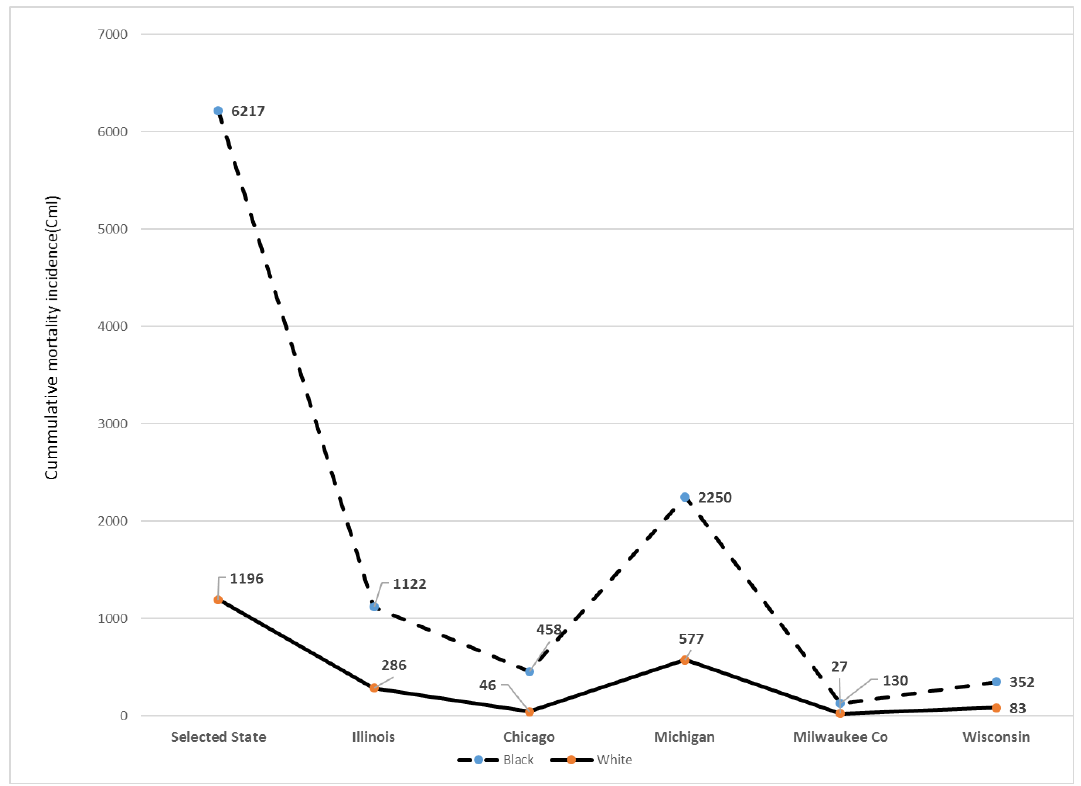
Figure 2. Cumulative incidence of COVID-19 mortality in mid-west states, USA, 9th April 2020. Co = county; in the mid-west states with data on race, mortality cumulative incidence (CmI) was higher among Blacks / AA relative to